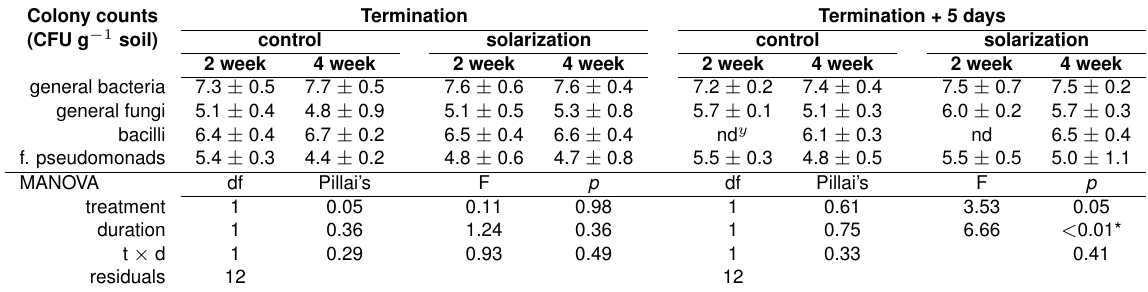
Table 2. Mean ± SD microbial colony counts from FIELD experiment and corresponding MANOVA results. Colony counts (CFU g − 1 soil)